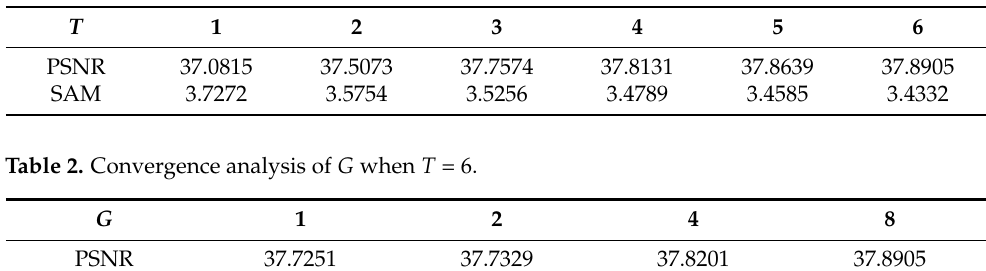
Table 1. Convergence analysis of T when G = 8.